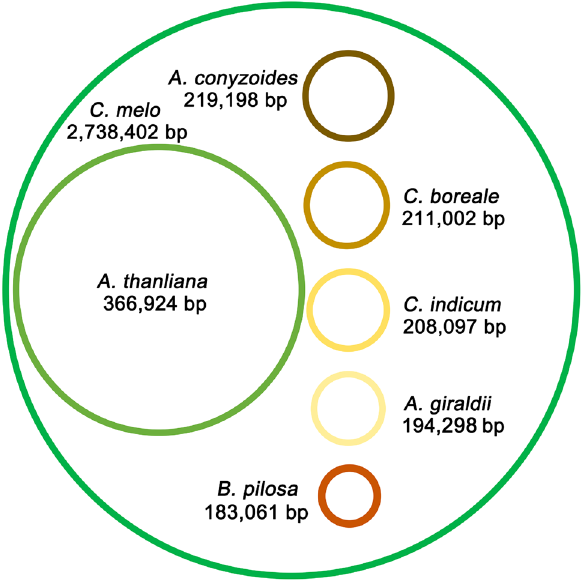
Figure 7. Comparison of mitogenome size between different species. Mitogenome sizes vary greatly among different plants. The outermost circle represents the size of the Cucumis melo mitogenome. The sizes of the circles are not drawn to